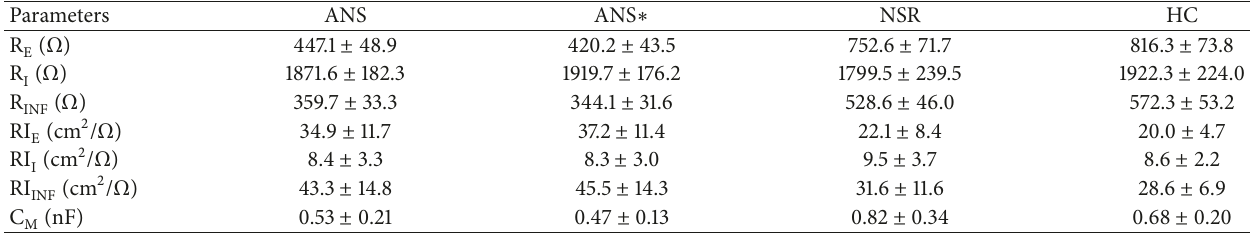
Table 4: Measured resistances (R), corresponding resistance indices (RI), and cell membrane capacitances (C M ) in the study. Parameters